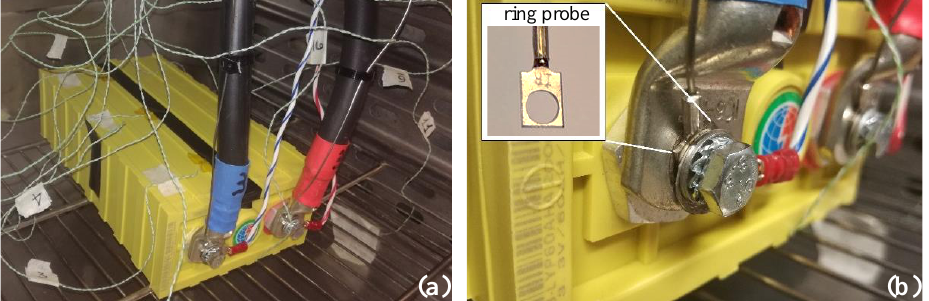
Figure 2. Equivalent electrical circuit for the lithium cell.